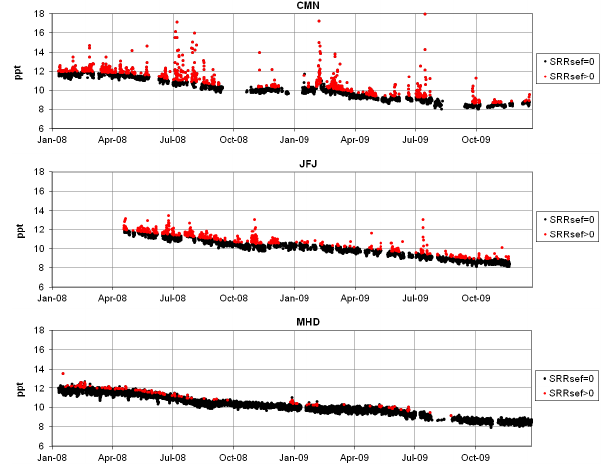
Figure 6. MCF time series at CMN, JFJ and MHD (January 2008– December 2009). Black and red dots represent times when, at the receptor sites, sensitivity to the SEF region (SRR SEF ) is = 0 and >0,